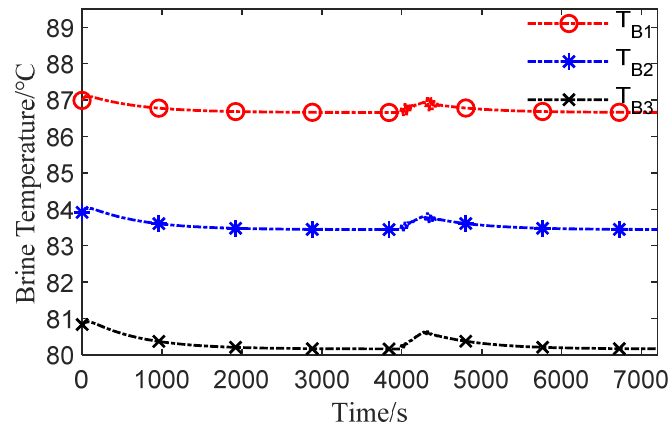
T for step increase in sea